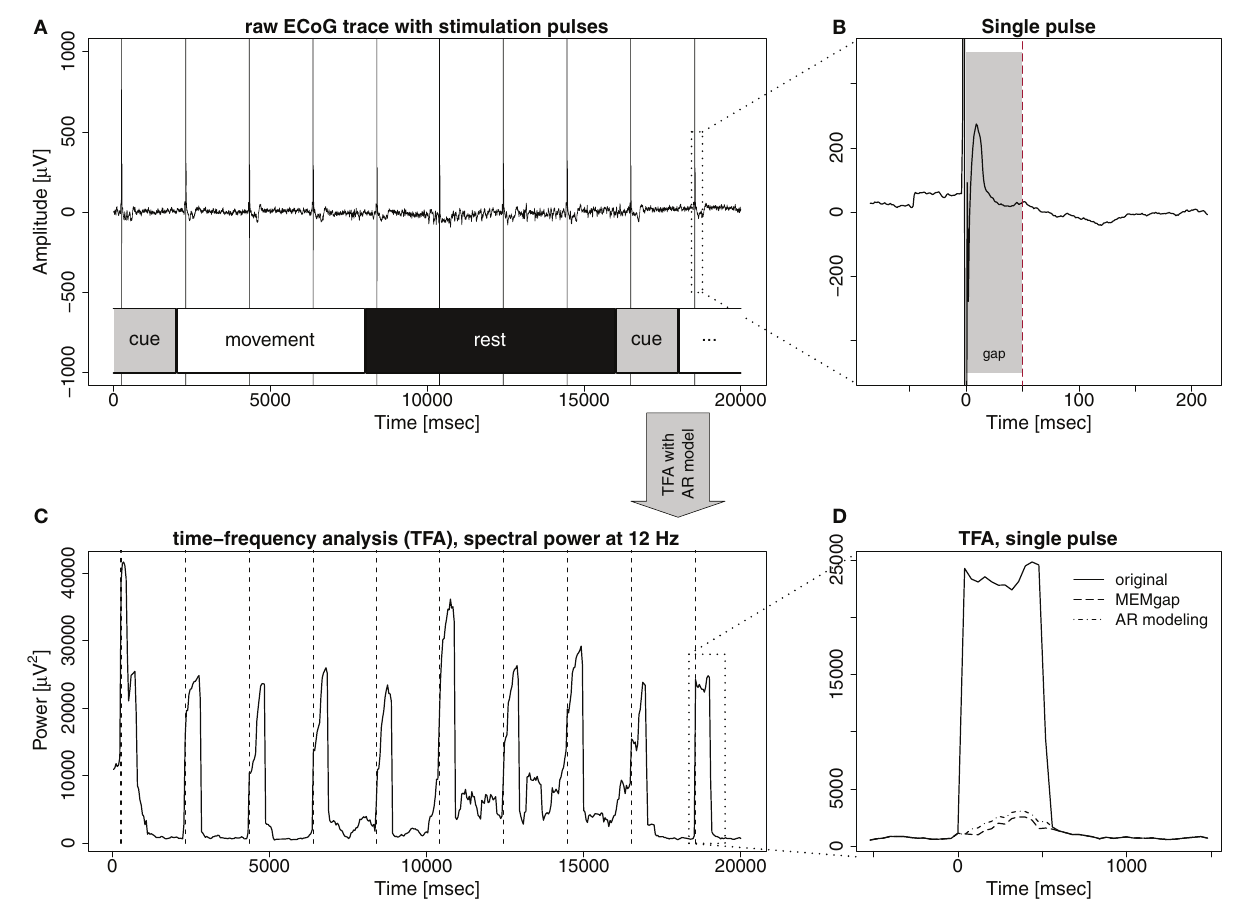
components are covered. (C) Time-course of the power at 12Hz of the signal displayed in (A) , resulting from a time-frequency analysis with auto-regressive models (order 16) when a window of 500ms is shifted in 40ms steps over the data. Hence, a single stimulation pulse distorts the spectrum for the next 500ms because it remains in the data window. (D) Zoom on the region of the last stimulation pulse. Power at 12Hz without stimulus processing (solid line) and when the gap is defined as in (B) and either MEMgap (dashed line) or AR modeling with order 16 (dashed-and-dotted line) are applied to deal with